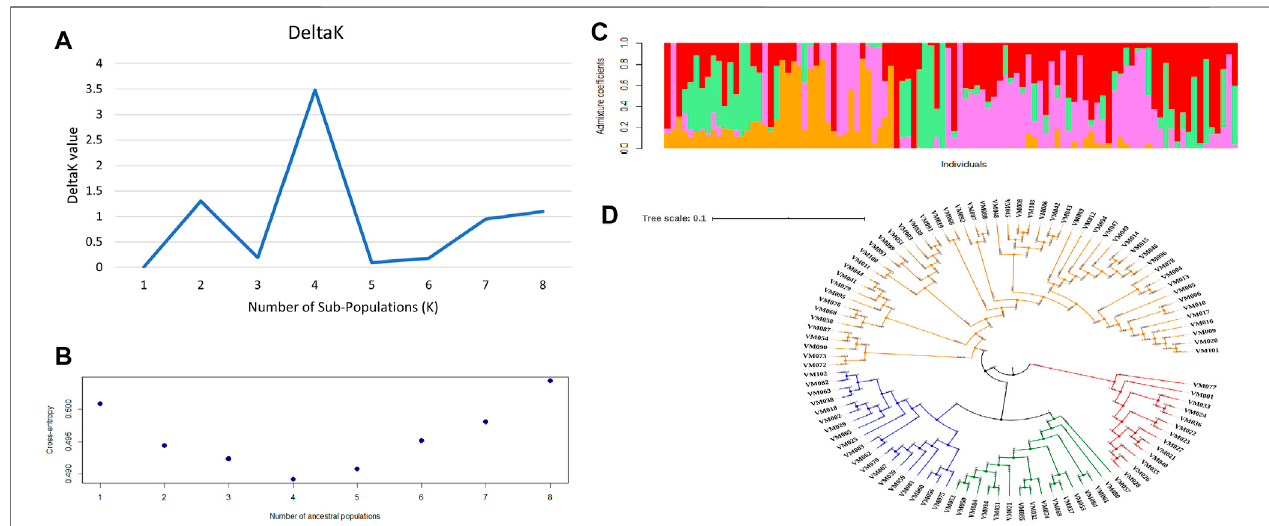
Frontiers in Genetics |